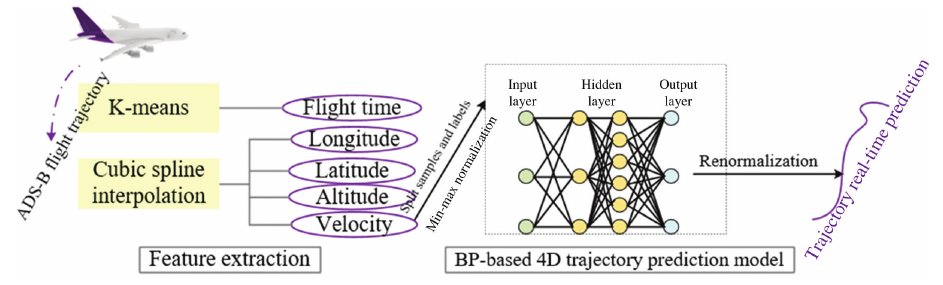
Figure 1: The Proposed BP-Based 4D Trajectory Prediction